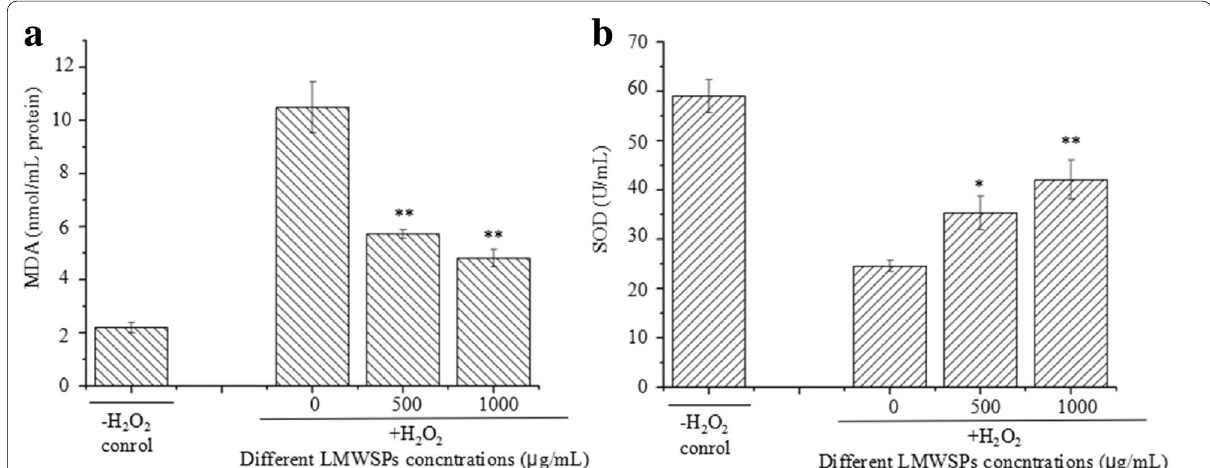
Fig. 5 Effect of LMWSPs on the MDA content and SOD activity in H 2 O 2 -treated L02 cells. Cells were pretreated with different concentrations of 0–3 kDa LMWSPs for 24 h before treatment with H 2 O 2 for 24 h. Each column represents the mean the H 2 O 2 control group)